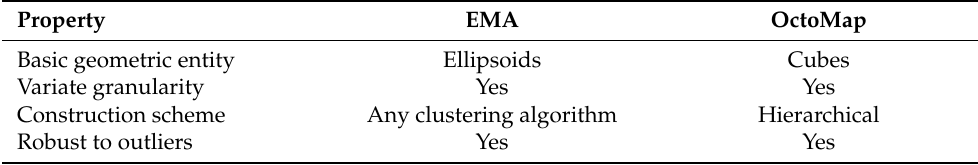
Table 1. EMA and OctoMap properties.